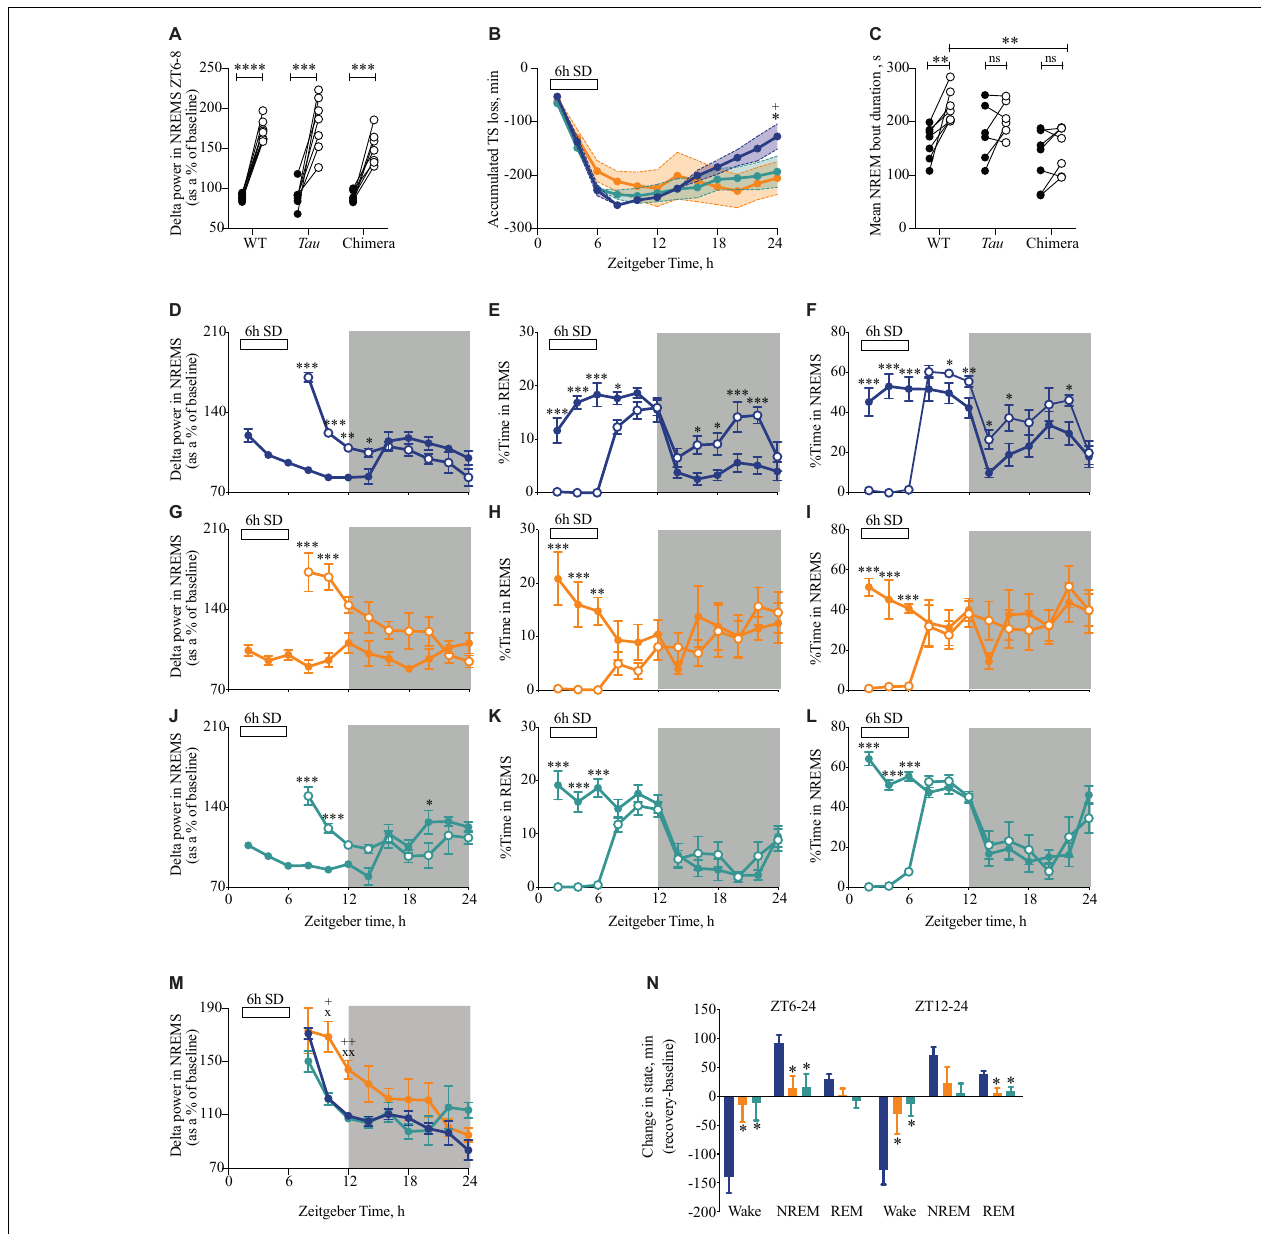
FIGURE 5 | Attenuated response to sleep deprivation (SD) in circadian chimeric mice. (A) Individual changes in EEG delta power in NREMS (1–4 Hz) (as a percentage of total power in baseline day) in the first 2 h of recovery sleep (ZT6-8; open circles) compared with baseline sleep (ZT6-8; closed circles) in WT, Tau and chimeric mice (two-tailed paired t -test show baseline vs. post-SD within genotype; ∗∗∗ p < 0.01, ∗∗∗∗ p < 0.0001). (B) The cumulative loss of total sleep (TS = NREMS + REMS) over the 6 h of SD with subsequent partial recovery of TS during the 18 h recovery period (ZT30-48) in WT (blue; n = 9), Tau (orange; n = 7), and chimeric (green; n = 7) mice (2xANOVA with post hoc Tukey’s multiple comparisons test p < 0.05, ∗ WT vs. chimera; +WT vs. Tau ). (C) Individual changes in the duration of bouts of NREMS (seconds) between ZT6-12 on baseline day (closed circles) and after 6 h SD (open circles) (Paired t -tests show baseline vs. 6 h SD difference within genotype ∗∗ p < 0.01; 1xANOVA with post hoc Tukey’s multiple comparisons test ∗∗ p < 0.01 WT vs. chimera). (D–L) Time course at 2 h intervals of delta power (mean ± SEM) in NREMS as a percentage of the total power during baseline (D,G,J) , REMS (E,H,K) , NREMS (F,I,L) in WT (blue; D–F ), Tau (orange; G–I ), and chimeric mice (green; J–L ) on the baseline day (closed circles) and following 6 h SD (open circles). (2xANOVA with post hoc Tukey’s multiple comparison test (REMS, NREMS) or Sidak’s multiple comparisons test (delta power in NREMS) ∗∗∗ p < 0.0001; ∗∗ p < 0.001, ∗ p < 0.01 vs. baseline day). (M) Time course at 2 h intervals of delta power (mean ± SEM) in NREMS (as a percentage of baseline) following 6 h SD in WT (blue), Tau (orange), and chimeric mice (green). (2xANOVA with post hoc Sidak’s multiple comparisons test x p < 0.05, xx p < 0.01 WT vs. Tau; + p < 0.05, ++ p < 0.01 Tau vs. chimera) (same data as plotted in D,G,J). (N) Differences between the change in state (mean ± SEM) for wake, NREMS and REMS following 6 h SD compared with baseline between ZT6-24 (light and dark phase of recovery) and ZT12-24 (dark phase only) in WT (blue), Tau (orange), and chimeric mice (green) (1xANOVA with Tukey’s multiple comparisons test p < 0.05 vs. WT; n =